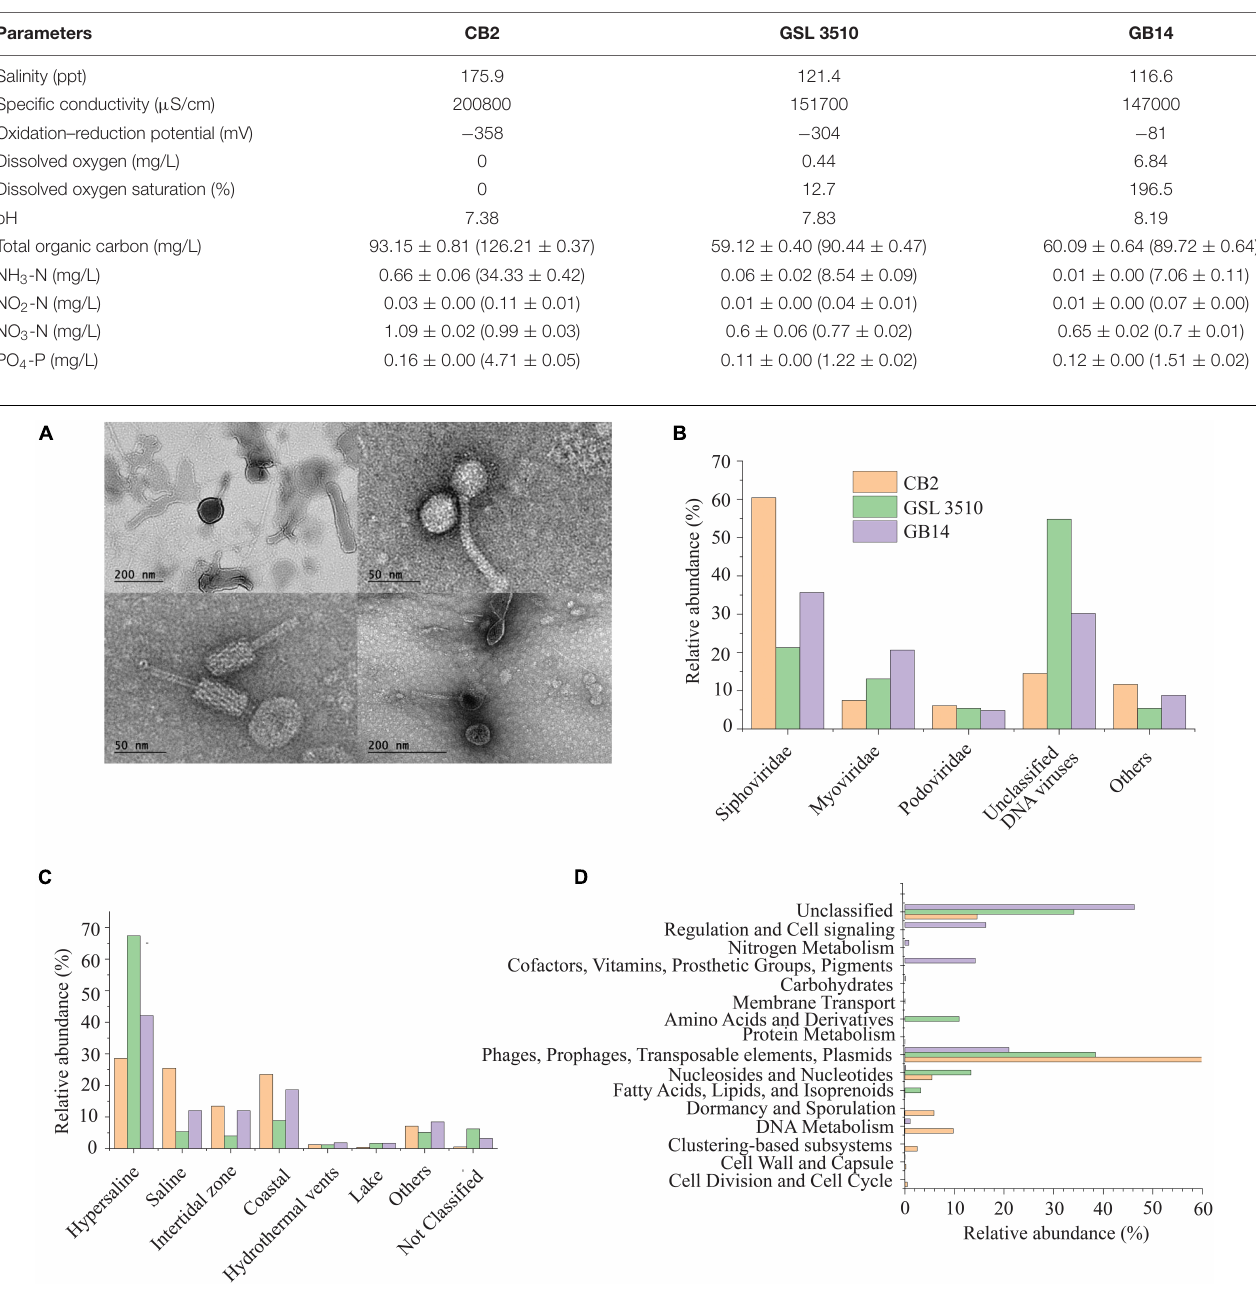
FIGURE 2 | (A) Morphological diversity of the viruses in the Great Salt Lake sediments observed via the transmission electron microscope (TEM). (B) Family level viral community composition from the Great Salt Lake sediments. (C) Ecosystem-based community composition of viruses from the Great Salt Lake sediments based on the similarity with viruses identified in different aquatic ecosystems (IMG/VR database). (D) Functional classification (SEED subsystem Level I) of the viral open reading frames (ORFs).